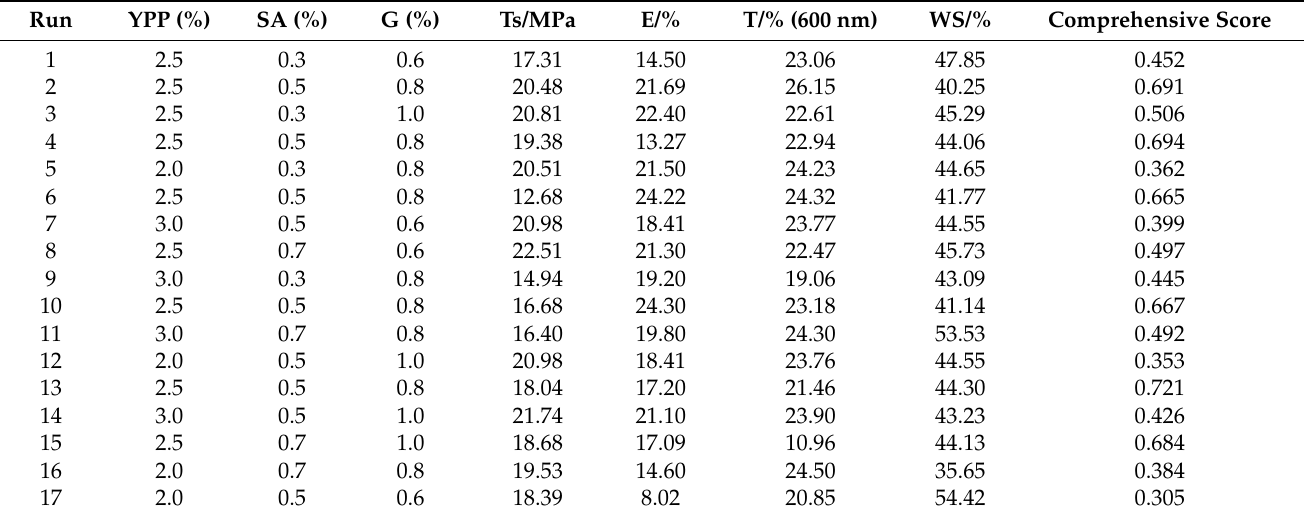
Table 4. Experiment design and